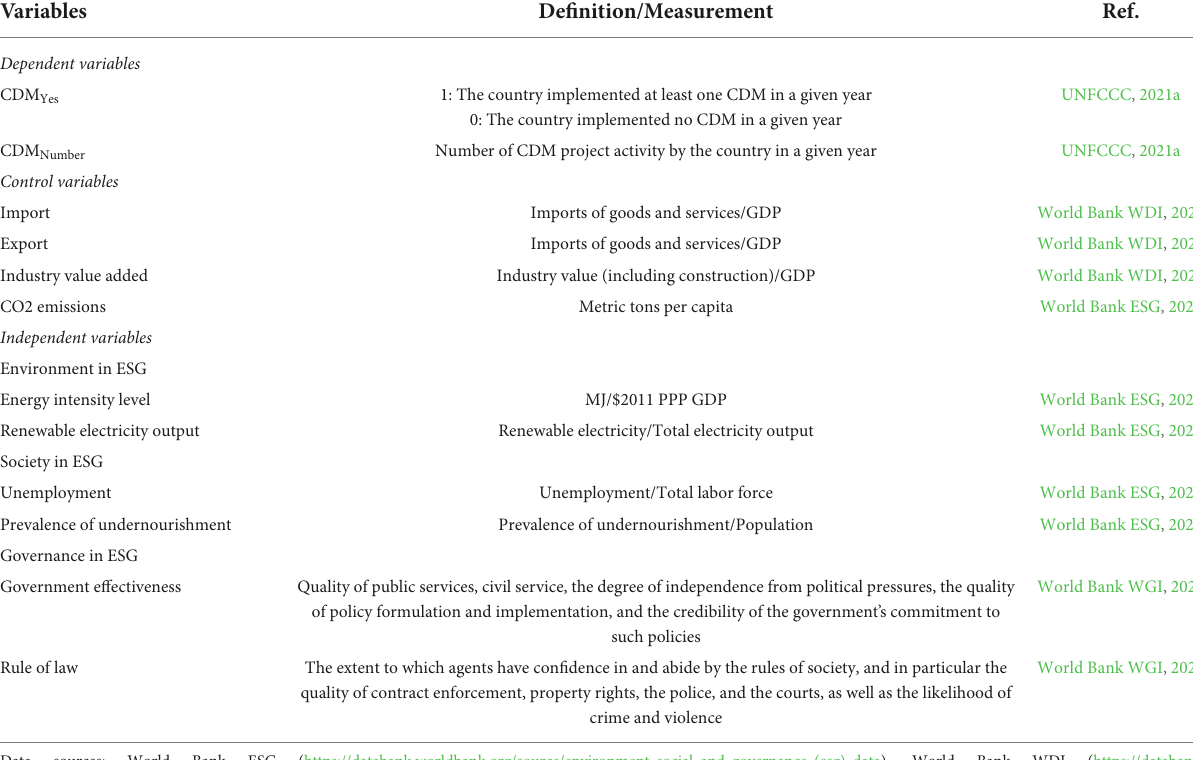
TABLE 3 Definition/measurement and reference of